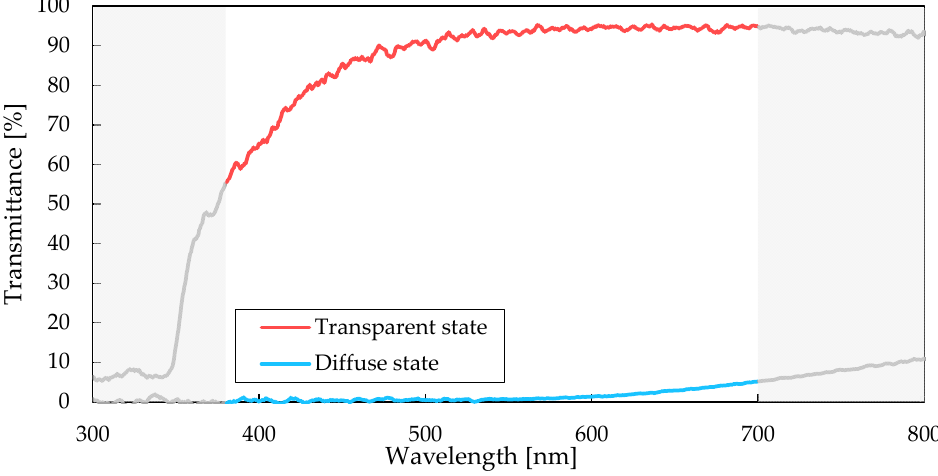
Figure 19. Spectral transmittance in diffuse and transparent diffuser-element states. For practical applications, a 33 mm × 22 mm four-element multi-focal optical element clear adhesive